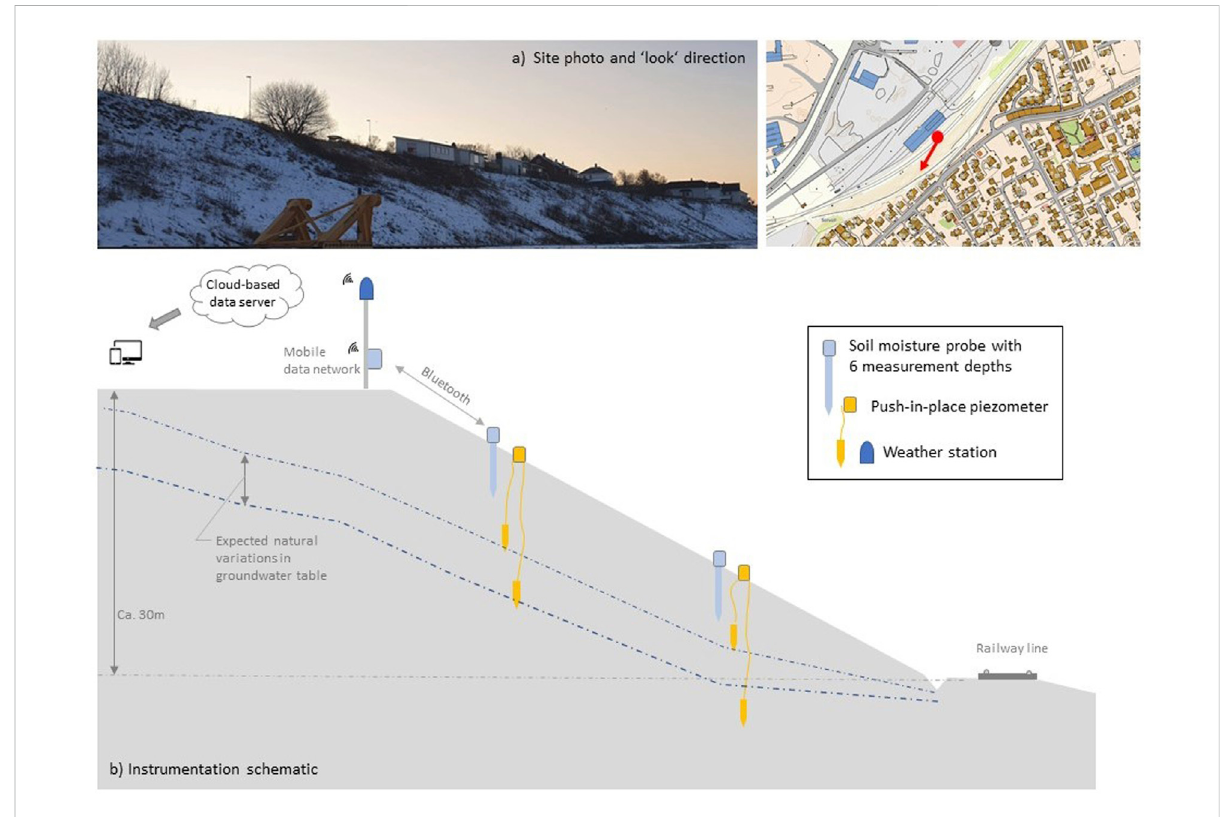
FIGURE 8 (A) Photo of the slope at Bodø station, and (B) schematic of the slope with